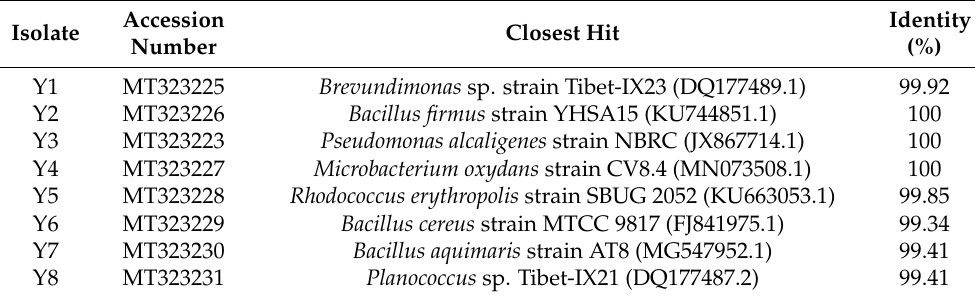
Table 1. Closest relatives of the 16S rRNA gene sequences of the isolated